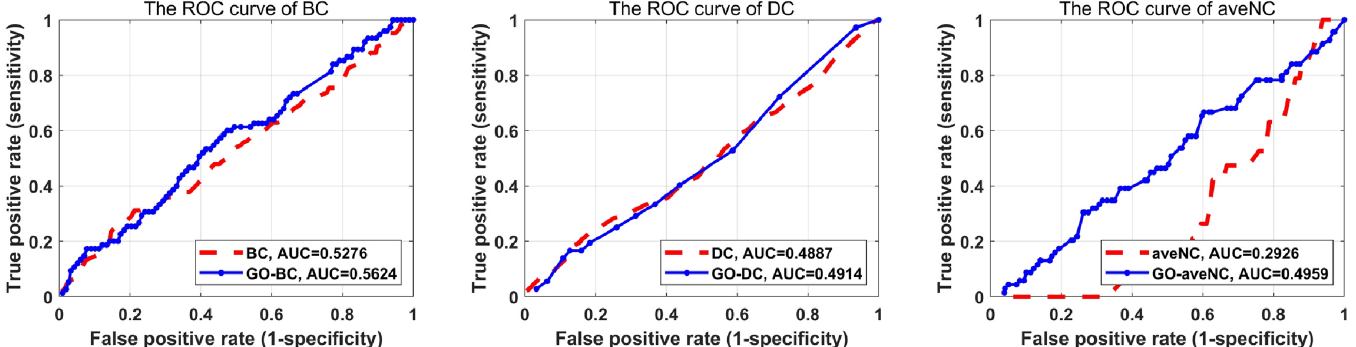
Fig 5. The comparison of ROC curves for original YDIP PPI network and Resink-BP (the Resink method under the BP subontology) PPI network under (left) BC method, (middle) DC method and (right) aveNC method.